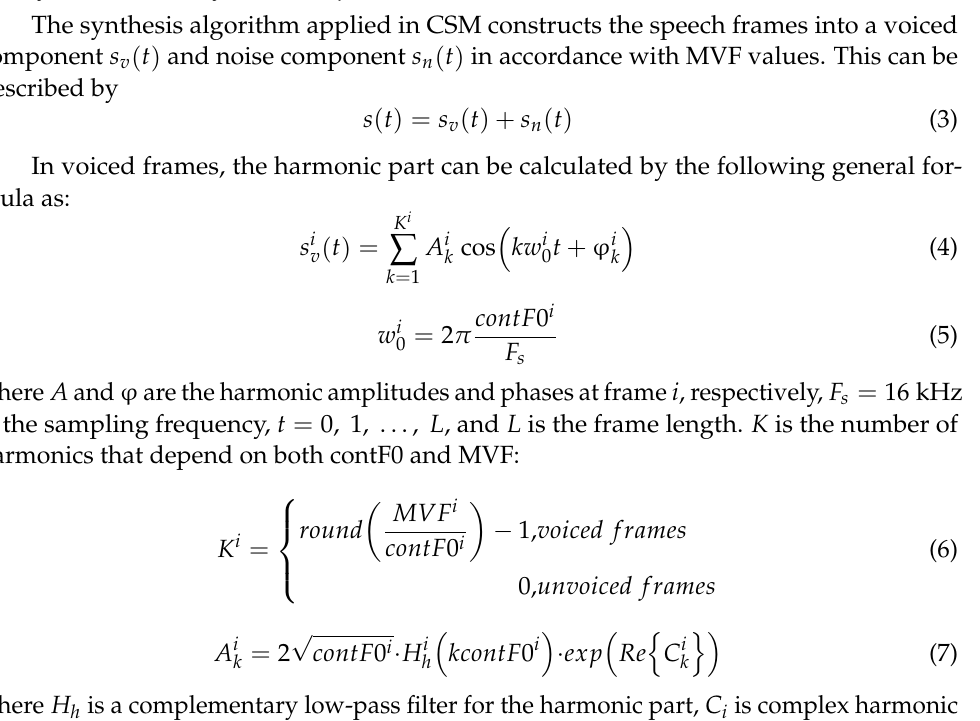
Figure 3. Given a speech frame, the sinusoidal model measures the F0 and the MGC representation of the spectral envelope (blue), and the MVF defined as the boundary between harmonic and noisy bands. Frequency bins are intervals between samples in the frequency domain.